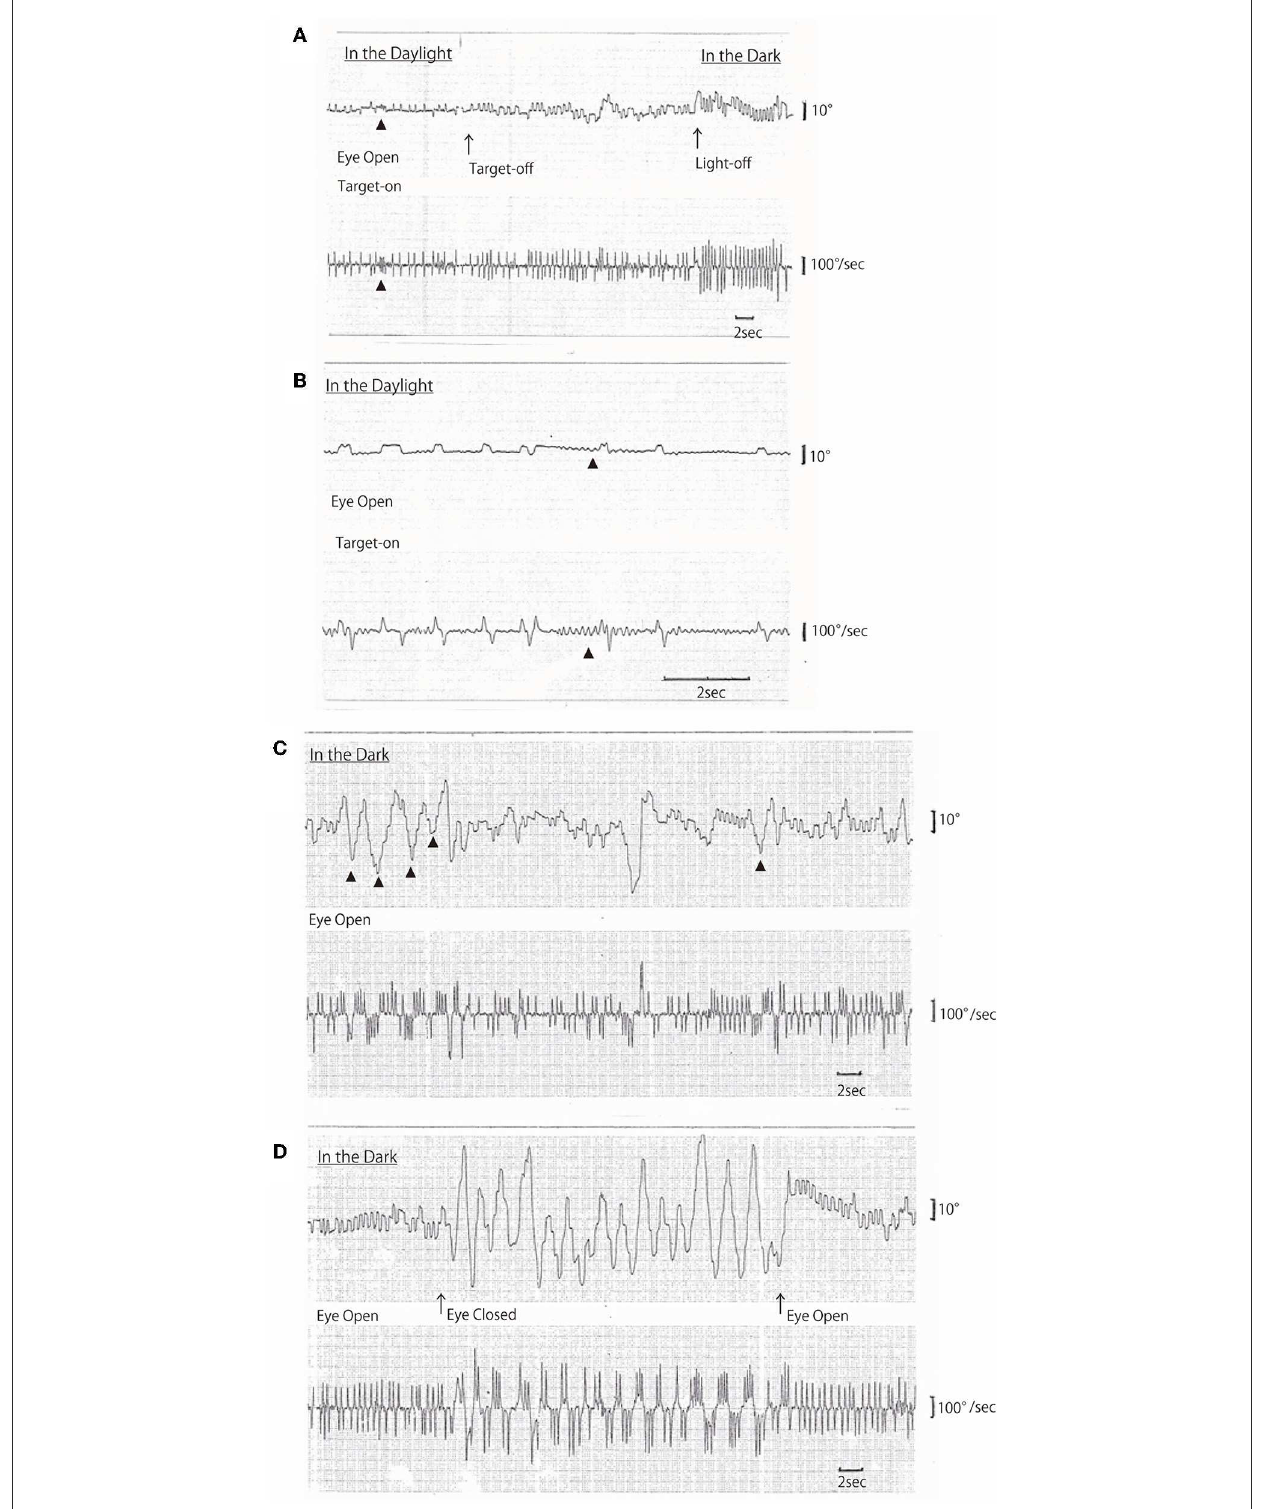
FIGURE1 (A – D) Horizontal AC-electrooculogram (EOG) recordings. In each figure, the upper graph shows semi-eye position (time constant 3s) and the lower graph shows eye speed (time constant 0.03s). In each graph, the upper direction indicates rightward eye movement, and the lower direction indicates leftward. Chart speed is 5 mm/s in (A , C, D) , and 25 mm/s in (B) . (A, D) were continuously recorded. (A) Square wave jerks (SWJs) occurred in the following three conditions: first, in the daylight under the target-on state; second, under the target-off (arrow) state; and finally, light-off (arrow) in the dark. The amplitudes of SWJs were 4–5 deg under target-on, 5–6 deg under target-off, and 6–8 deg in the dark. The frequency of SWJs also gradually increased as follows: 1Hz under target-on state, 1.5Hz under target-off state, and 2Hz in the dark. Ocular